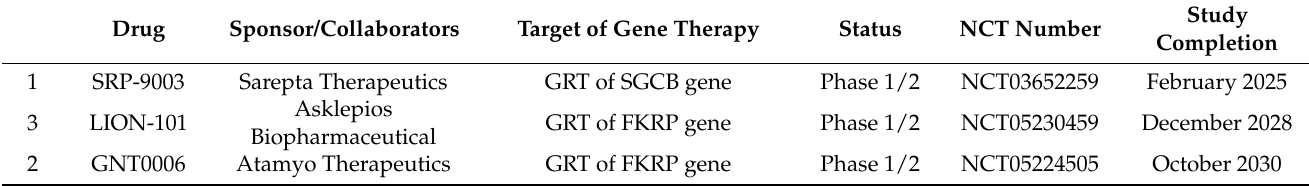
Table 4. Gene-specific therapies for LGMD tested in clinical